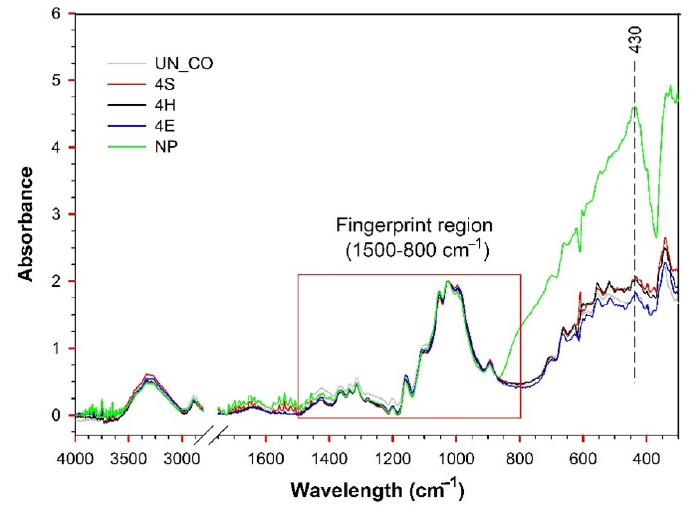
Figure 3. IR ATR spectra of untreated and TiO 2 functionalized cotton fabric samples.